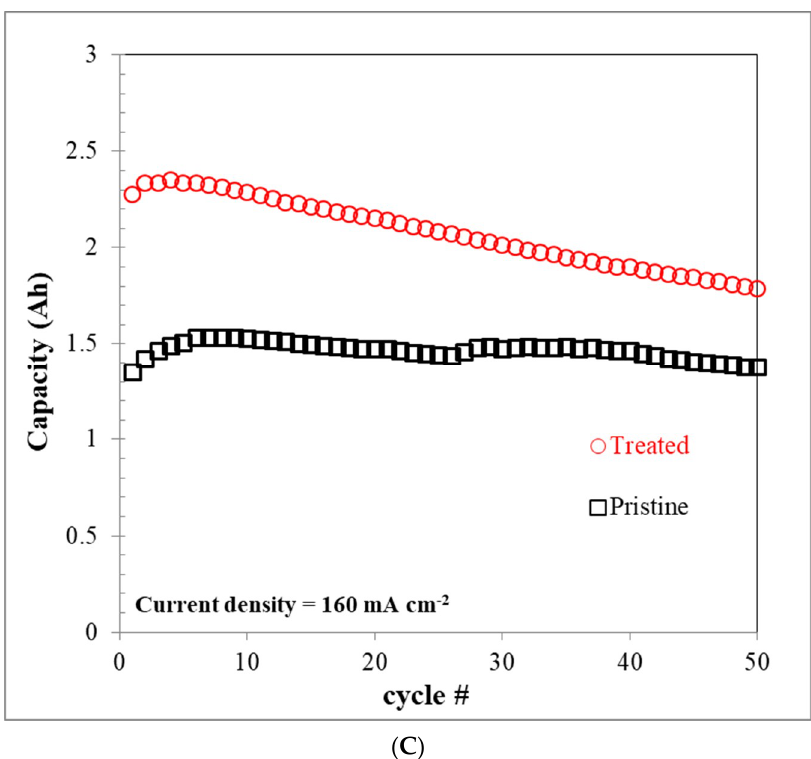
Figure 9. Diagrams of the performance of vanadium redox flow battery (VRFB). ( A ) One-hundred cycles of efficiency (%) performance of VRFB with the atmospheric plasma treated carbon felt. Fifty cycles of ( B ) efficiency (%) and ( C ) capacity (Ah) performance with and without atmospheric plasma treated carbon felts. EE, energy efficiency; VE, voltage efficiency; CE, coulombic efficiency.